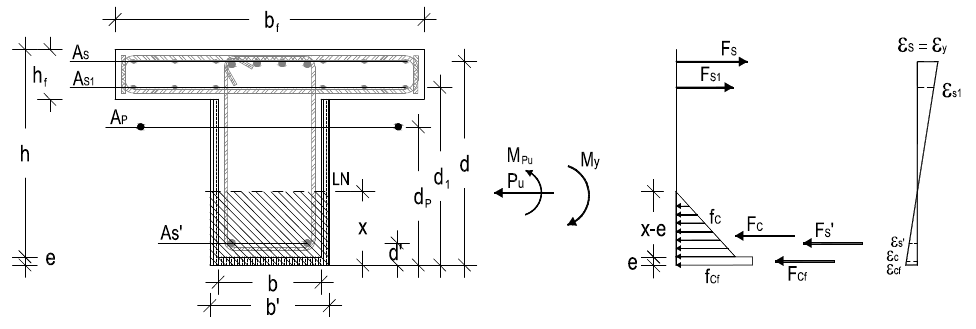
Figure 16. Section force equilibrium—yield moment.